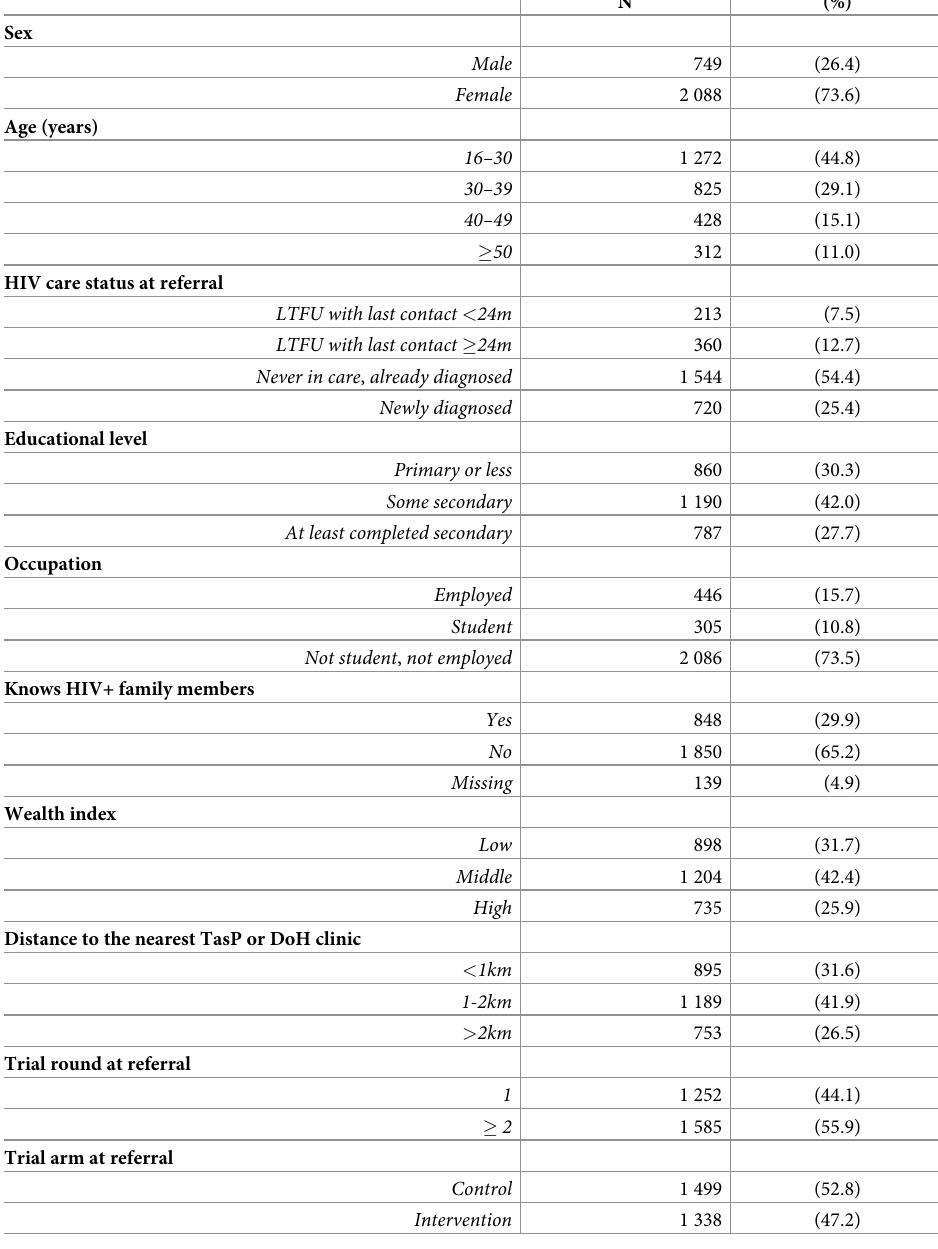
Table 1. Characteristics at first home-based referral of included individuals (N = 2 837). ANRS 12249 TasP trial.